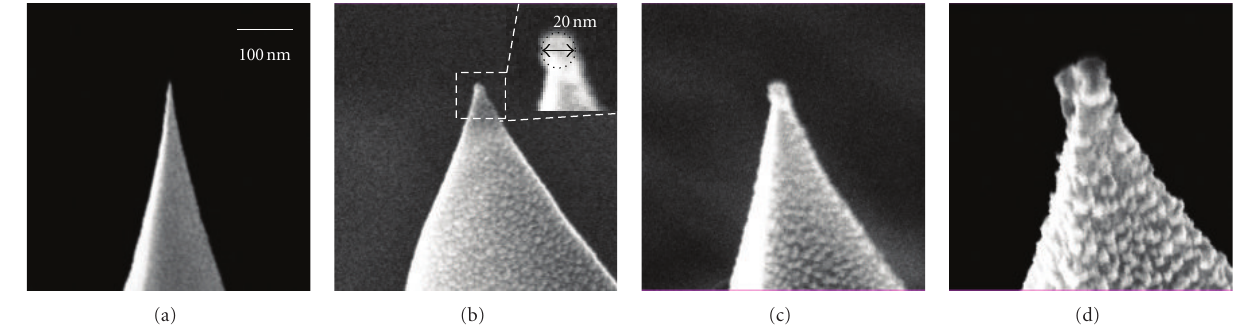
Figure 4: SEM images of several ANSOM probes with varying thickness of silver coating. (a) Bare silicon probe with no silver coating, (b) probe with 20 nm silver coating, (c) probe with 40nm silver coating, and (d) probe with 60nm silver coating. The zoomed inset shows how we estimate the apex size.